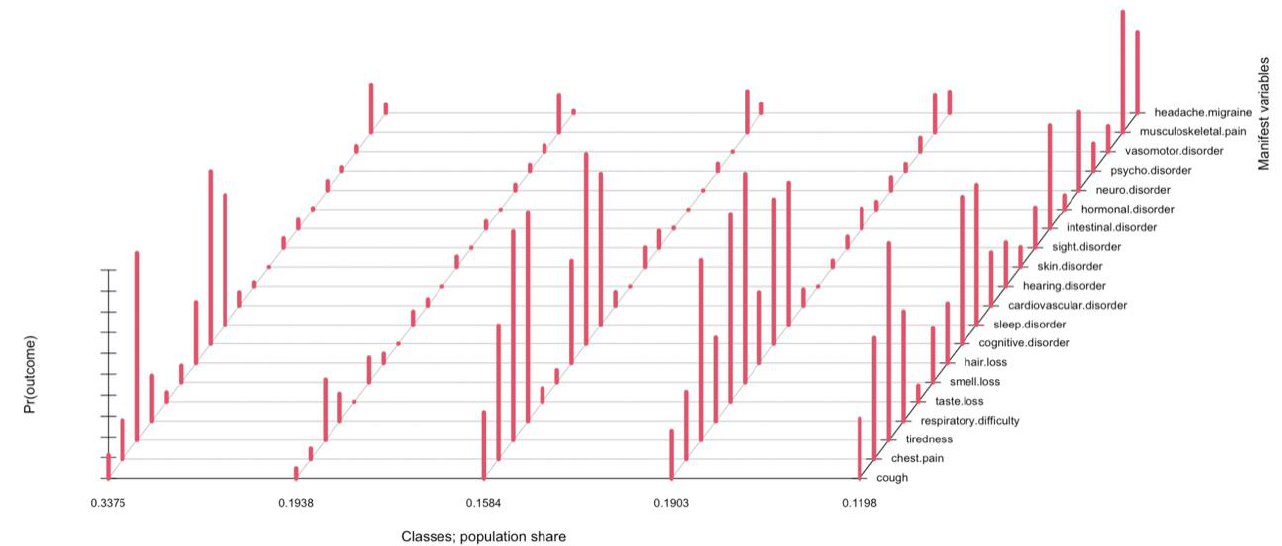
Figure 1. Composition of long COVID-19 symptoms in the latent classes.